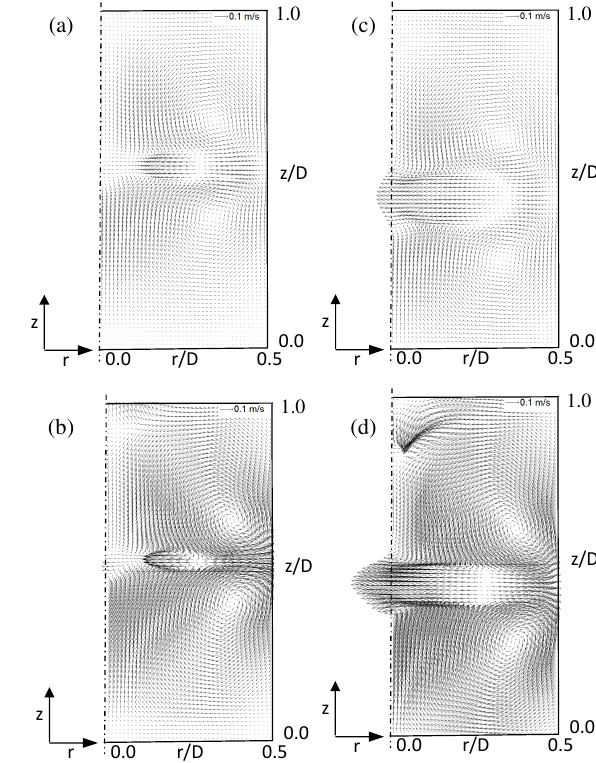
Fig. 7. Mean velocity field for h/H =1/4 and Rushton turbine (a,b), novel impeller (c,d) and rotational speed N =100 rpm (top), N =300 rpm (bottom).